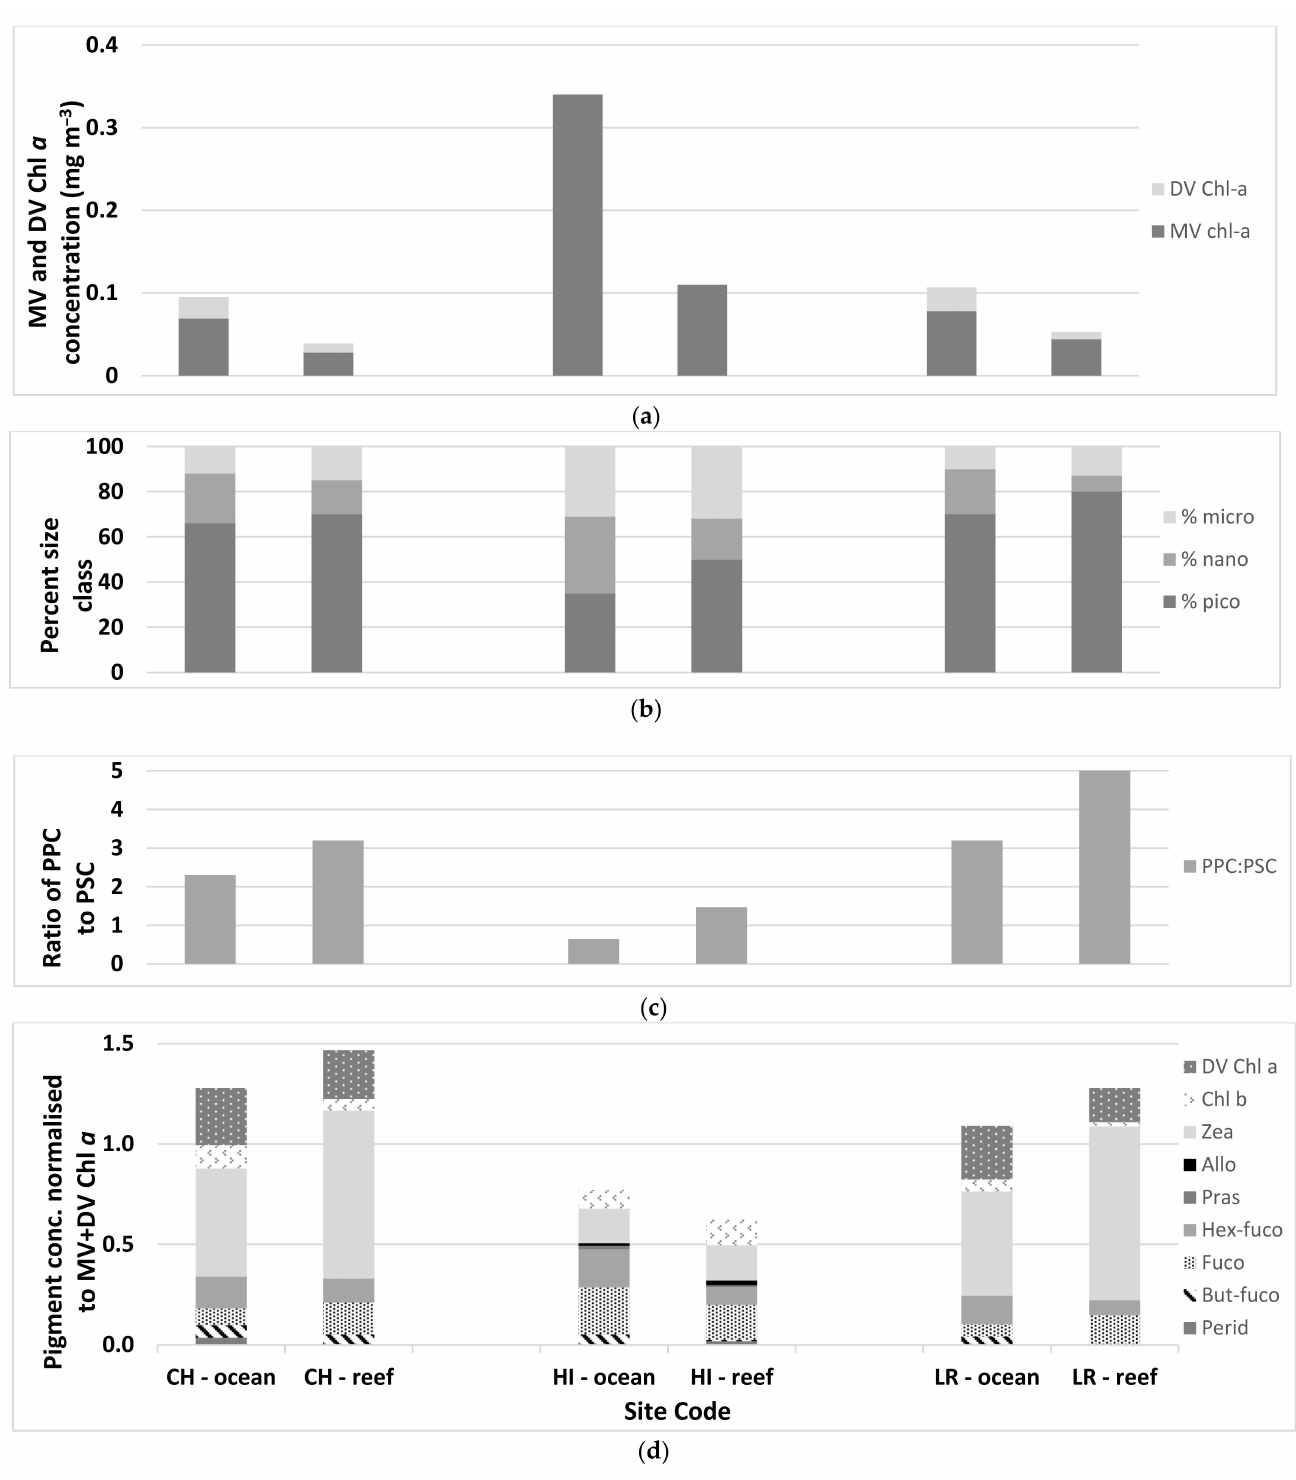
Figure 3. A comparison between the reef and ocean sites at Coringa-Herald Reef (CH), Heron Island (HI), and Lihou Reef (LR) for ( a ) average values of concentration of MV and DV Chl a , ( b ) percent size class for the pico-, nano-, and microplankton, ( c ) ratio of the photoprotective carotenoids (PPC) to photosynthetic carotenoids (PSC), ( d ) pigment composition based on the pigment concentration normalized to MV+DV Chl a